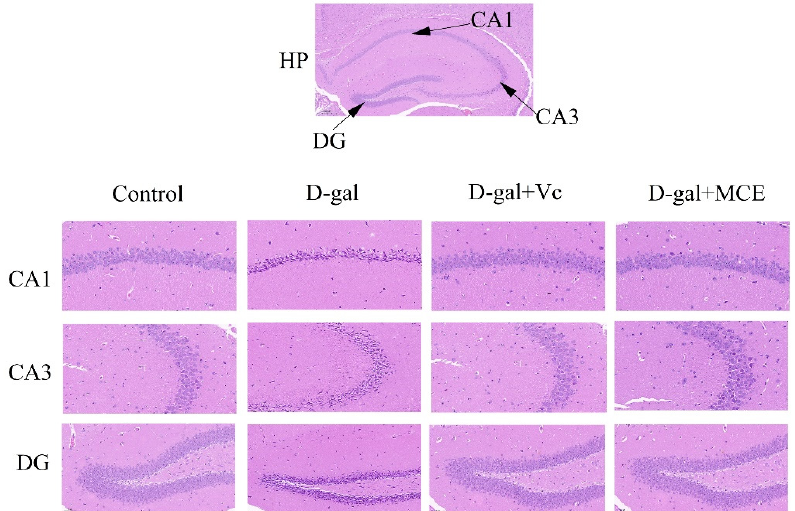
Figure 6. Effects of MCE on hippocampus (HP) with H&E staining (magnification 400 × , scale bars